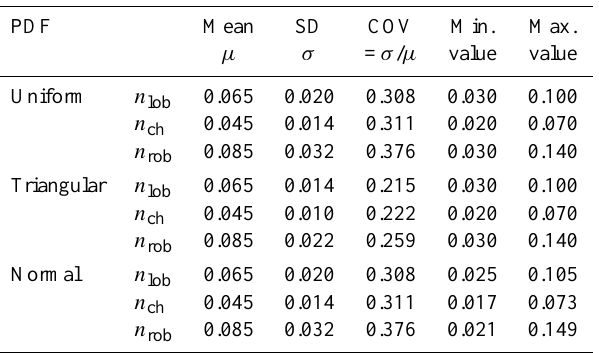
Table 1. Probability Distribution Functions (PDF) for bed friction coefficient, n .